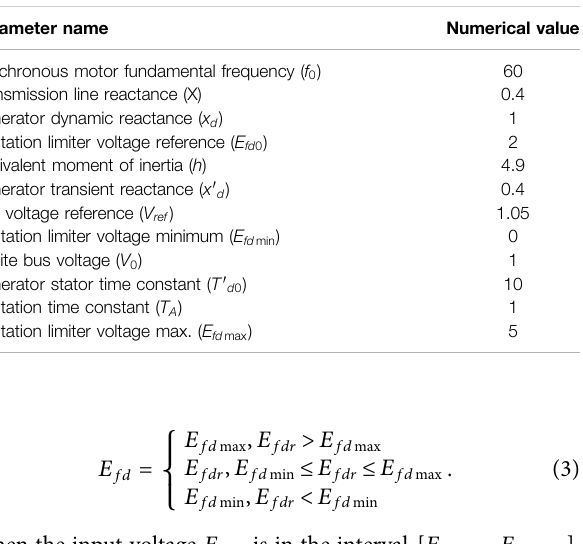
TABLE 1 | System parameter